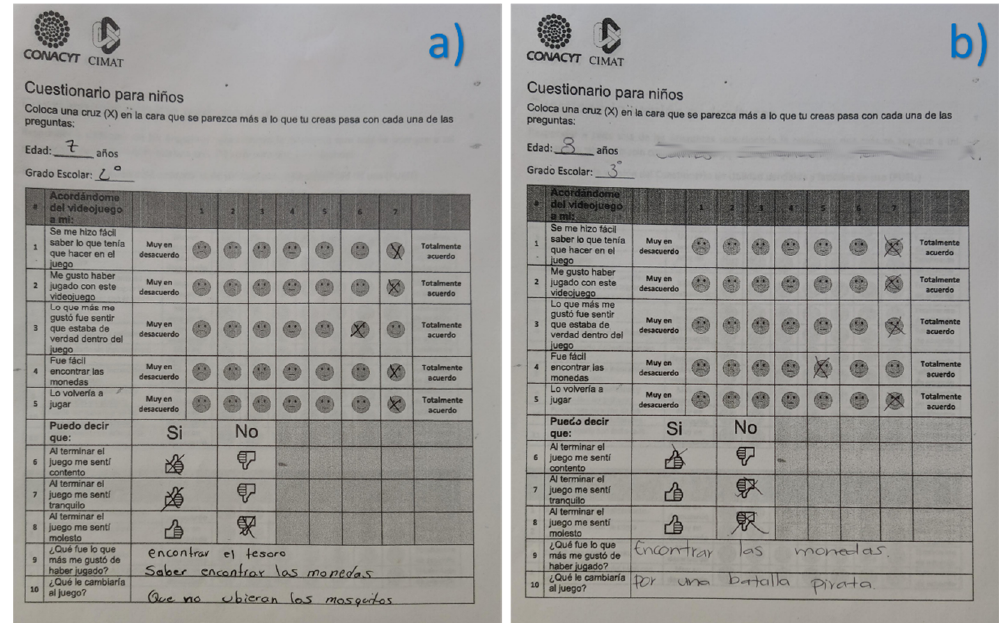
Figure A7. Assessment instruments Perception of use and satisfaction questionnaire applied to regular children (a) and ADHD children (b).